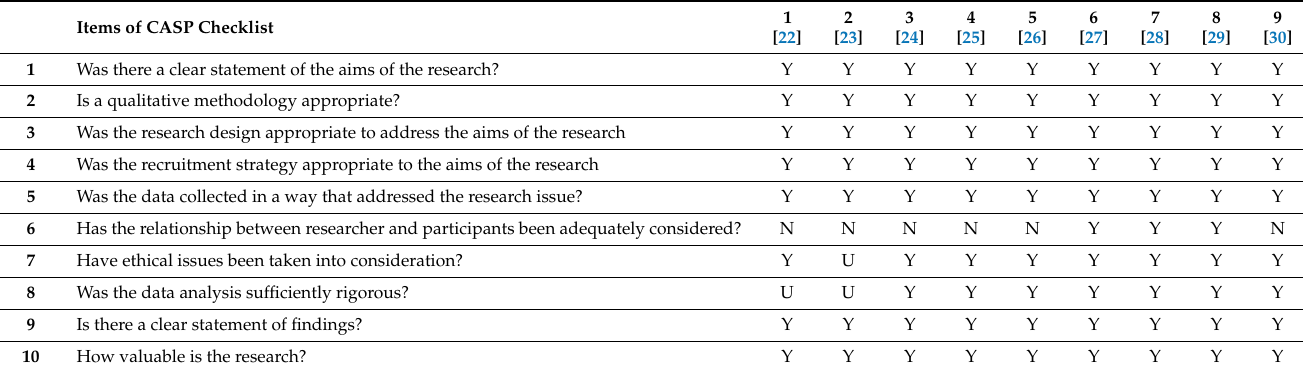
Table 1. CASP Qualitative Studies Checklist